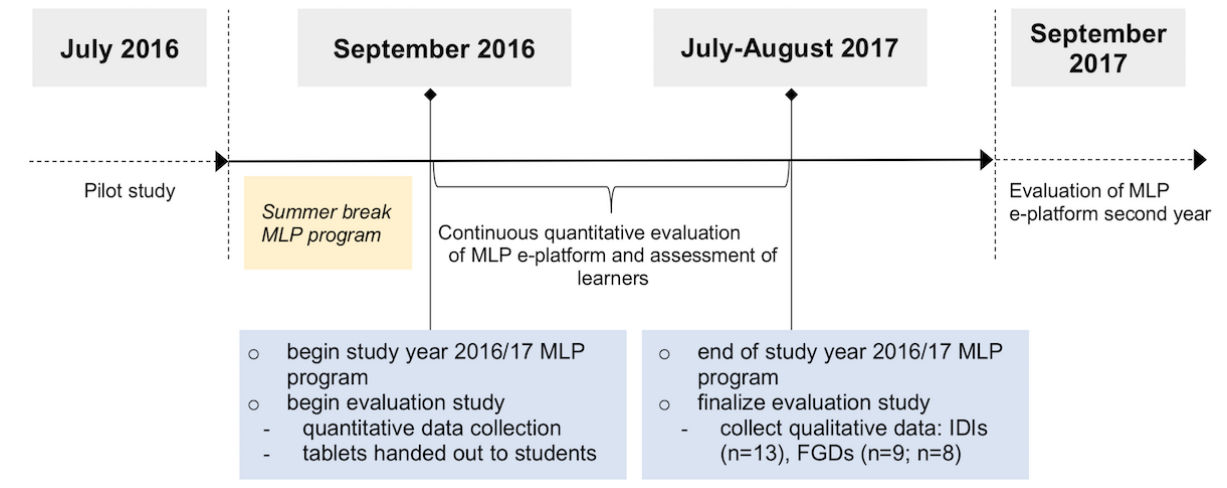
Figure 1. Timeline of study events in chronological order. MLP: medical licentiate practitioner; e-platform: e-learning platform with an eHealth component; IDIs: in-depth interviews; FGDs: focus group